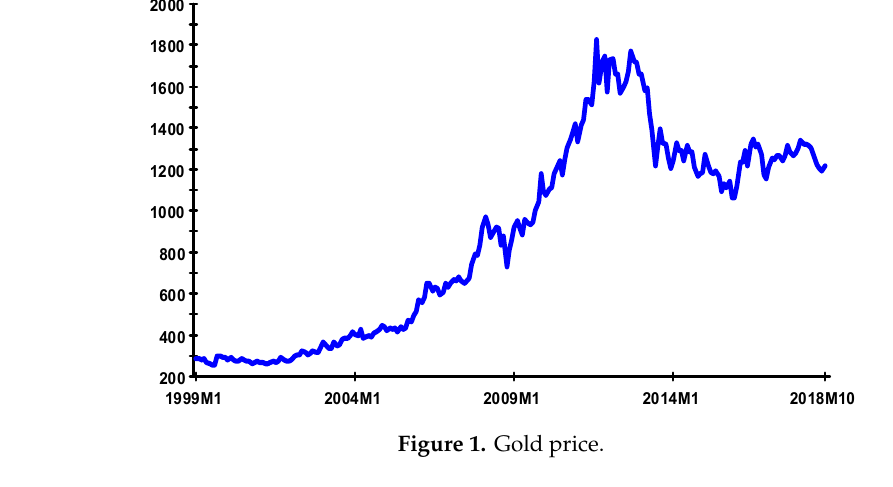
Figure 1. Gold Figure 1. Gold price.